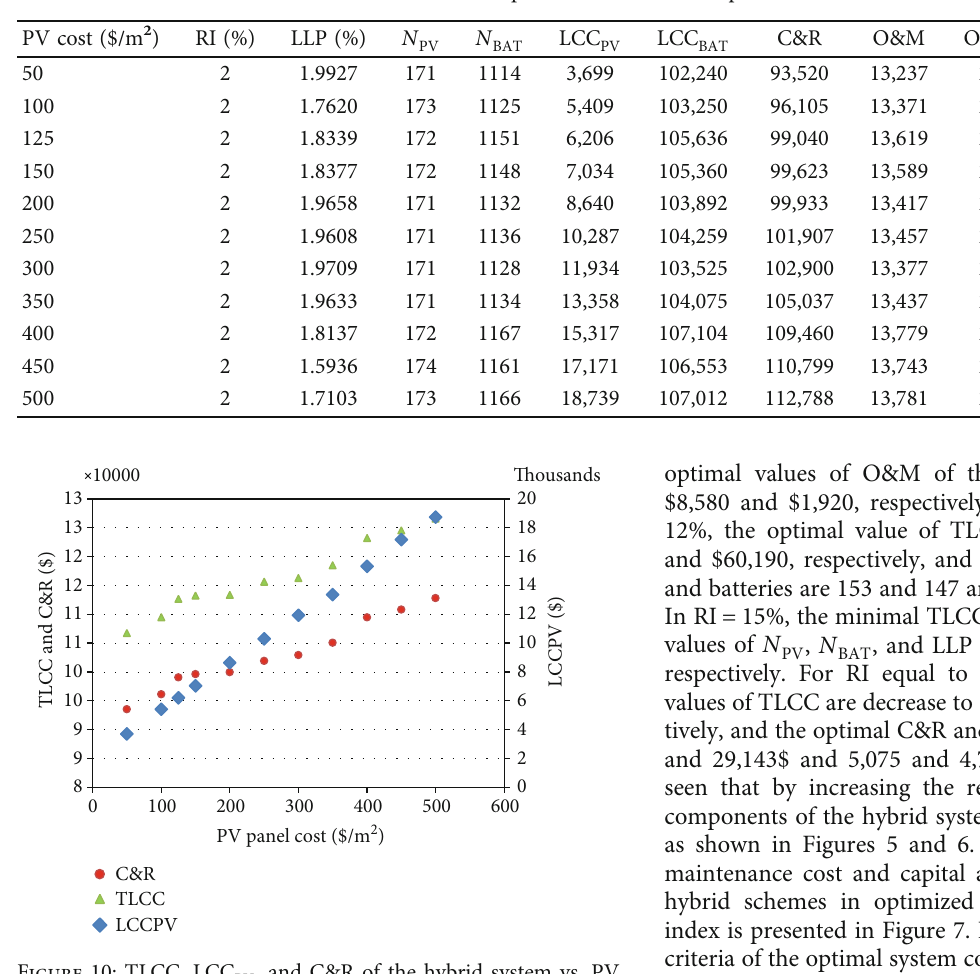
Figure 10: TLCC, LCC PV , and C&R of the hybrid system vs. PV panel unit cost in the optimal condition.